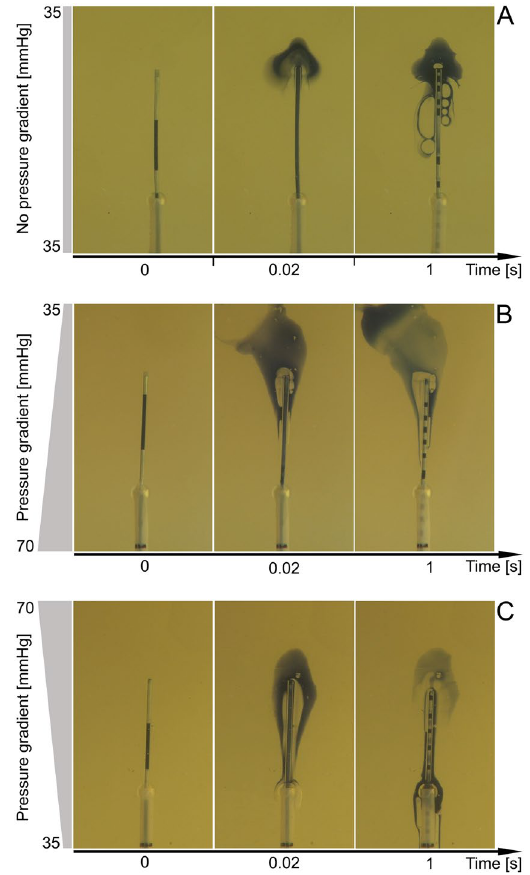
Figure 1. Propagation of the transferred load within the model of the uterine cavity. ( A ) no pressure-gradient force between proximal and distal parts of the model; ( B ) lower pressure in distal (35 mmHg) than proximal (70 mmHg) parts of the model; and ( C ) higher pressure in distal (70 mmHg) than proximal (35 mmHg) parts of the model.